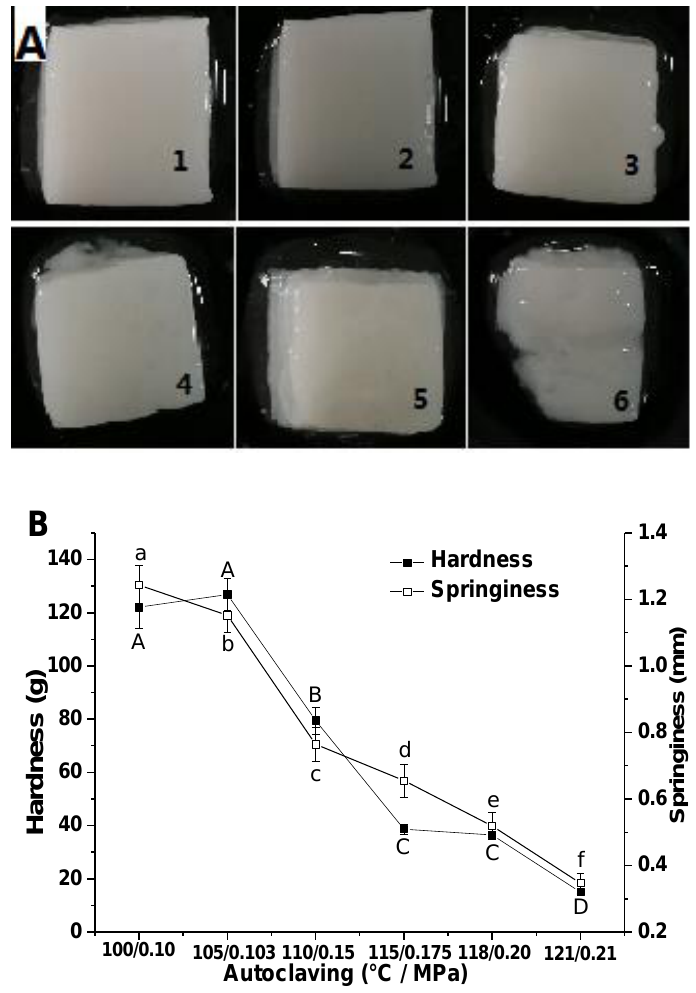
Figure 1. Effect of autoclaving on appearance ( A ) and texture ( B ) of CMP heat-induced gel. The gels from 1–6 in A are obtained by treating CMP solutions at 100 ◦ C/0.1 MPa, 105 ◦ C/0.103 MPa, 110 ◦ C/0.15 MPa, 115 ◦ C/0.175 MPa, 118 ◦ C/0.20 MPa and 121 ◦ C/0.21 MPa, respectively. In B, different letters indicate significant difference in hardness (uppercase) and springiness (lowercase) between different samples ( p < 0.05). Bars indicate standard deviations of the means ( n ≥ 3).